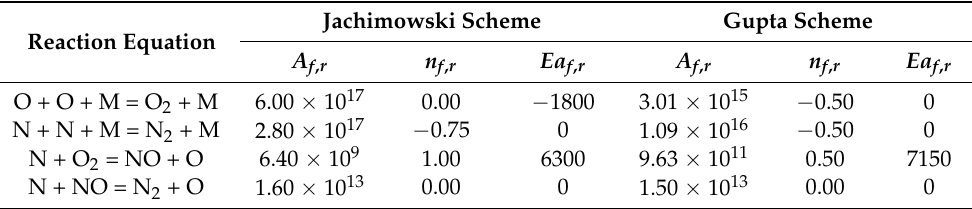
Table 6. Comparison of reaction rate coefficients between Jachimowski scheme and Gupta scheme. Reaction Equation